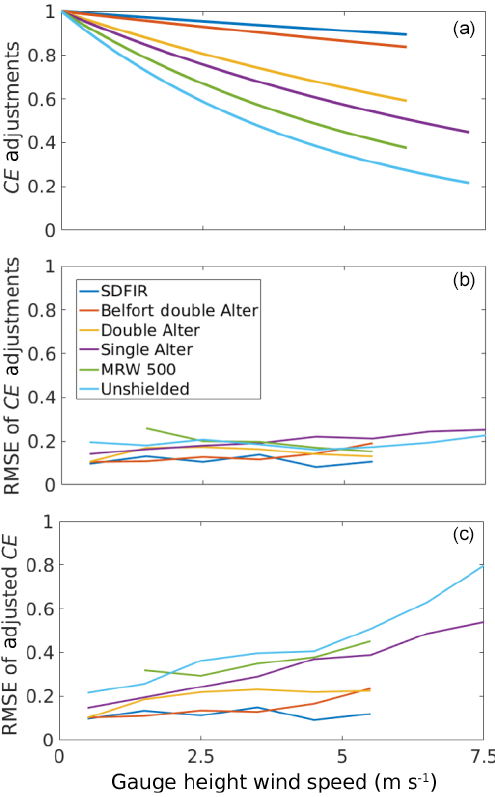
Figure 7. (a) Comparison of recommended Eq. (1) catch efficiency (CE) adjustments at T air = − 5 ◦ C. (b) RMSE of the CE adjustments, estimated by bin-averaging for every 1ms − 1 of wind speed. (c) RMSE of the adjusted CE bin-averaged by wind speed, estimated by adjusting the measurements and calculating RMSE values from the resultant catch efficiencies. The SDFIR, Belfort double-Alter, standard double-Alter and MRW500 transfer function coefficients were determined from the results presented here. The single-Alter shielded and unshielded results are from K2017a. Bin-averaged RMSE values are only shown (b, c) when more than 30 values were available within a given 1ms − 1 wind speed